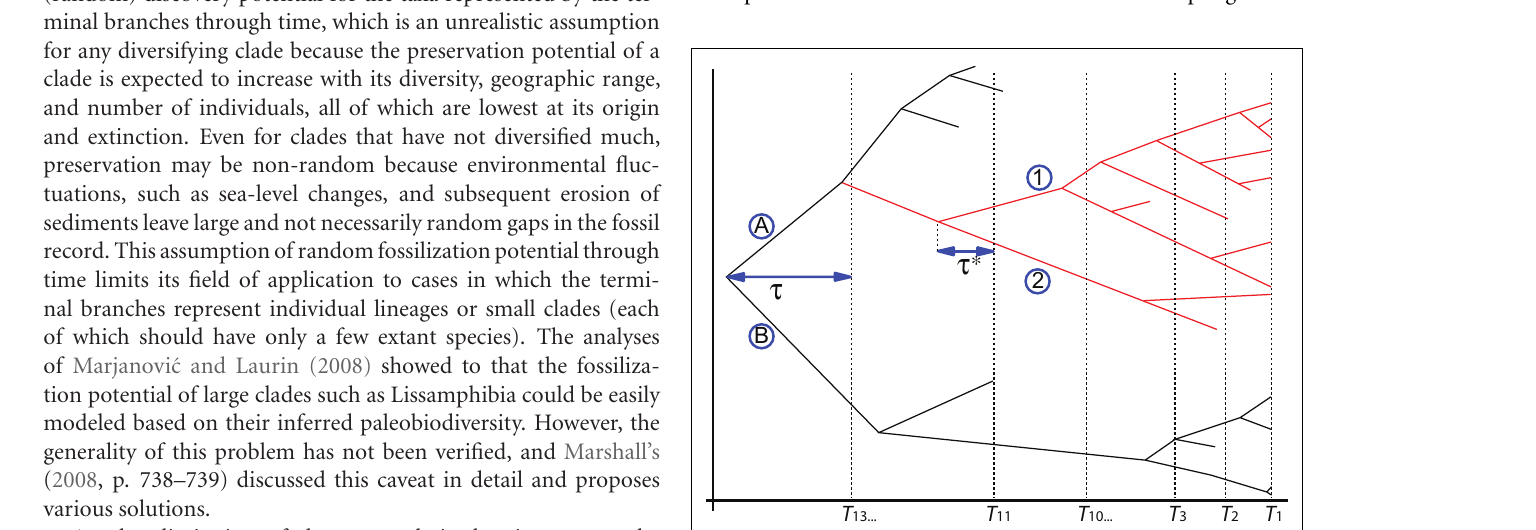
FIGURE 6 |A primate tree used byWilkinson andTavaré (2009) to explain their method and to obtain probability distributions on the times of origin of anthropoids (clade in red) and crown-group primates. The oldest anthropoid dates fromT11 and the oldest crown primate fromT13 ( Table 1 ).Thus, the unknown gaps in the earliest fossil record of primates and anthropoids, here denoted τ and τ *, respectively, are the time intervals that need to be estimated to know the true times of origin of these two clades.The four clades denoted by alphanumeric symbols are: A, Haplorhini ; B, Strepsirhini ; 1, Platyrrhini ; 2,